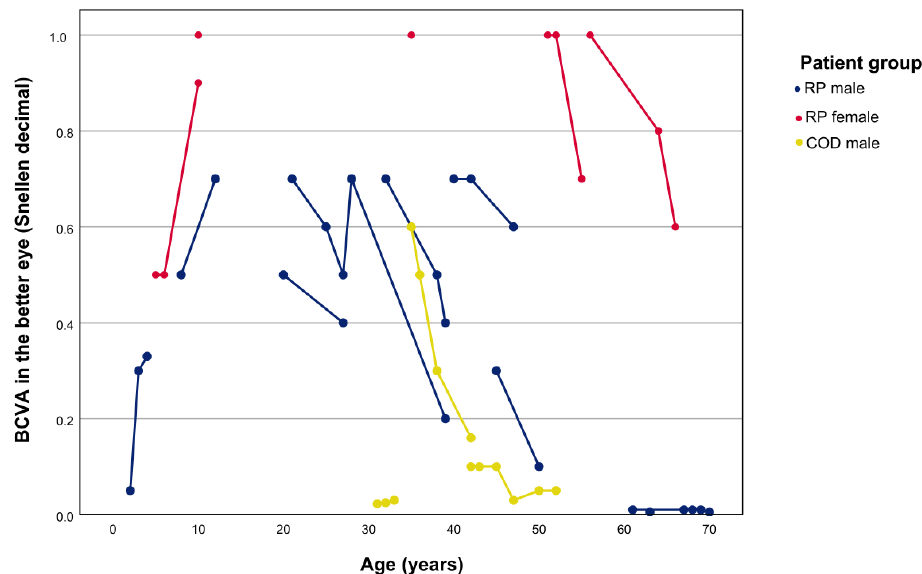
Figure 13. BCVA analysis in all the patients according to age and diagnosis. Note the increasing VA with visual development and/or increased ability to quantify VA in younger patients. In addition, note the similar age-dependent visual loss in male COD patients in comparison to male RP patients even though there was a large difference in age at disease onset. A dot not connected to a line means the patient had only one measurement.